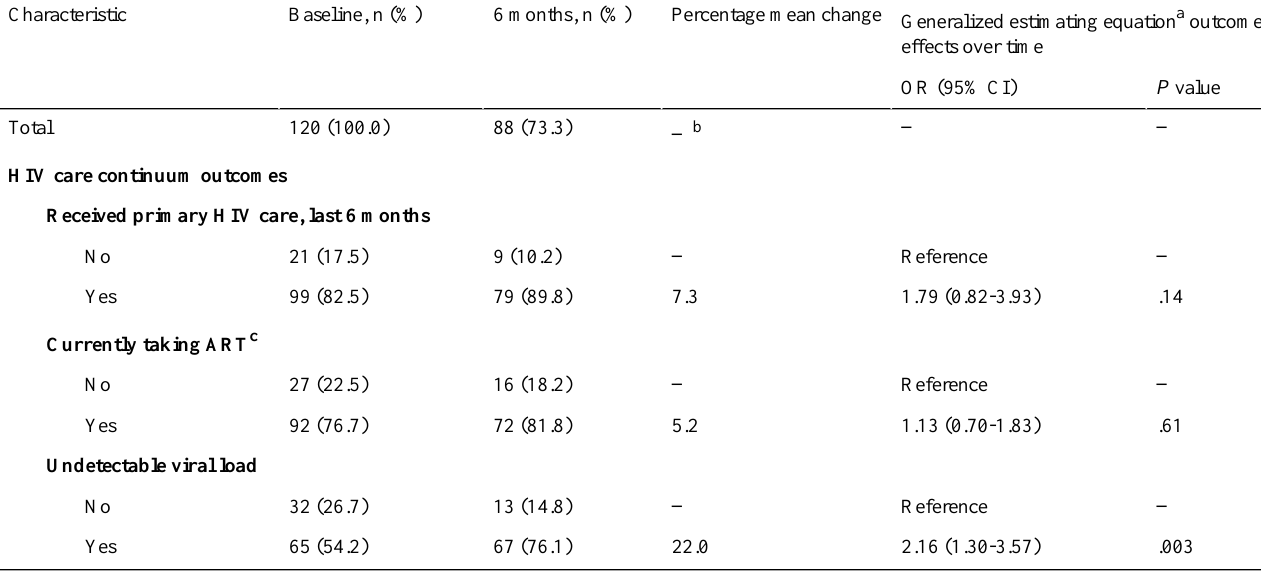
Table 2. Differences in HIV care continuum outcomes at baseline and 6 months among men who have sex with men and transwomen living with HIV (Health eNav,